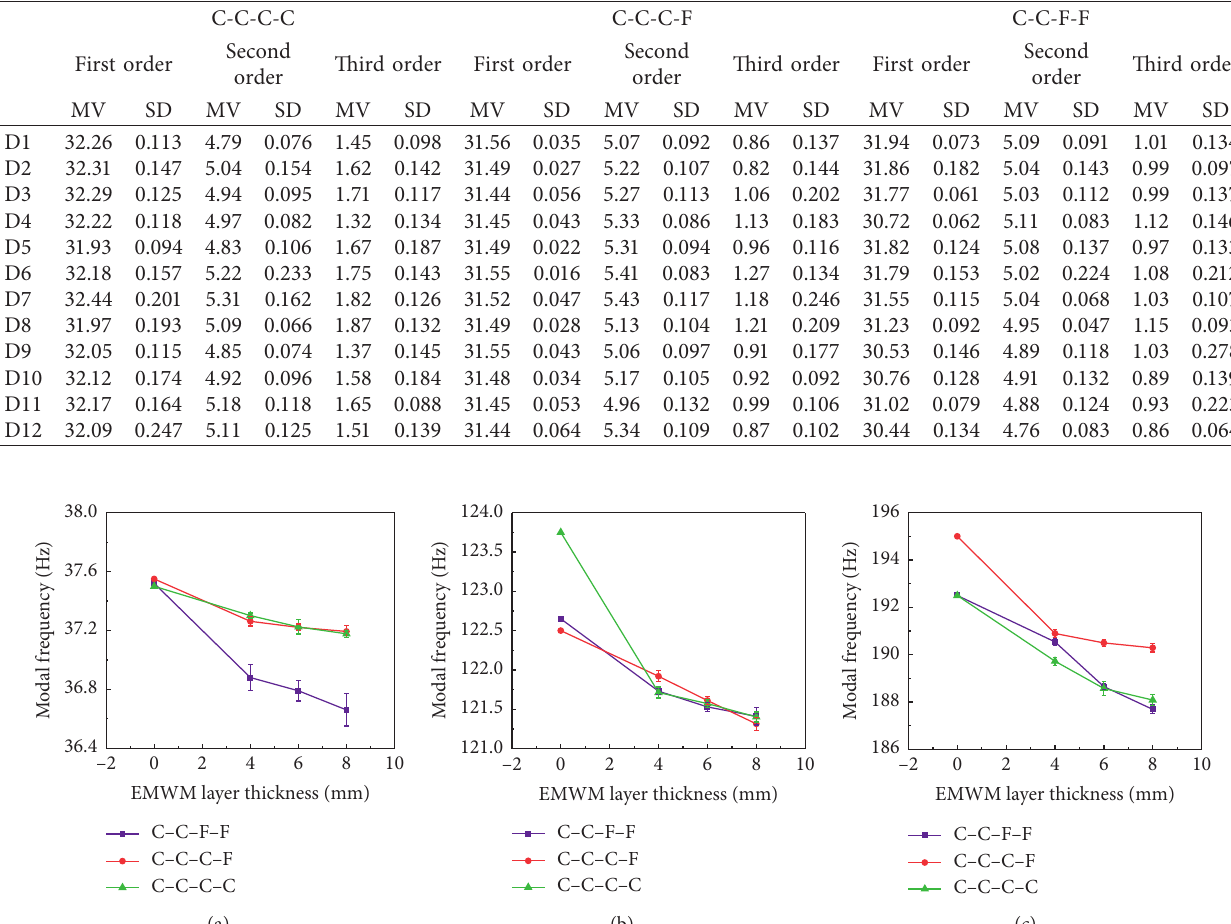
Table 4: Displacement deviation at measure points (D1 ∼ D12) under different boundary conditions. (unit: μ m).